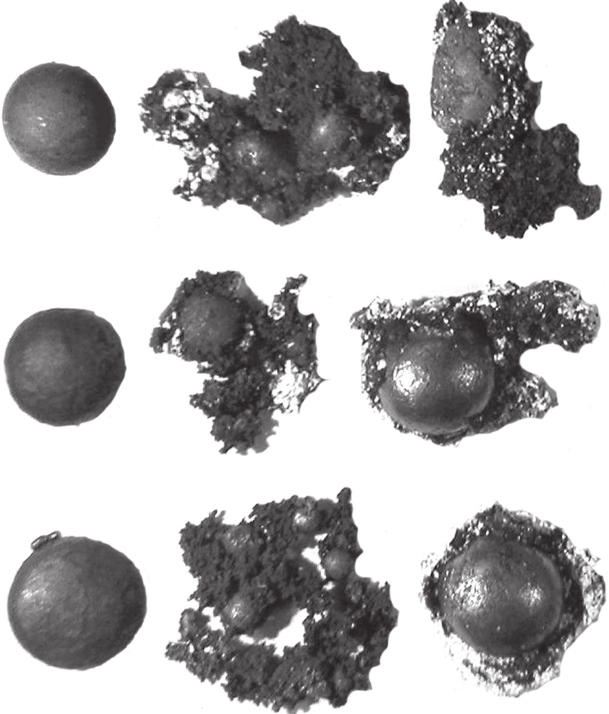
Figure 5. Left: iron-carbon nuggets without ashes formed from pellets with metallic iron and graphite; center: several small iron-carbon nuggets formed from pellets with metallic iron, graphite and high liquidus temperature slag; right: iron-carbon nuggets separated from the low liquidus temperature